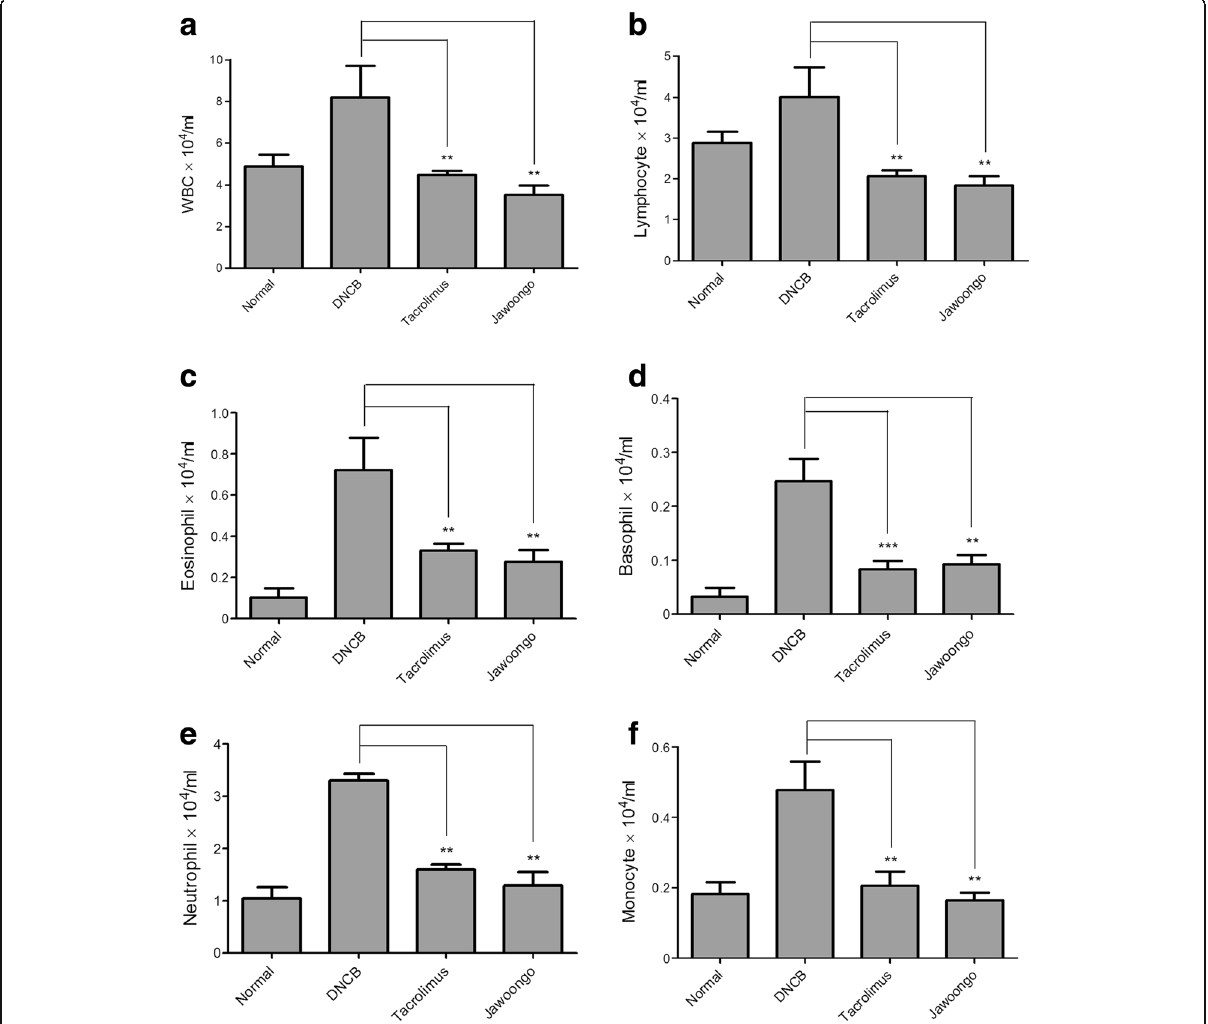
Fig. 3 Jawoongo reduced leukocyte numbers in the blood. Blood samples were analyzed using a HEMAVET 950 hematological analyzer. The data were presented as mean ± SEMs ( n = 8 mice/group). * P < 0.05, ** P < 0.01 and *** P < 0.001 as compared to DNCB-stimulated group,